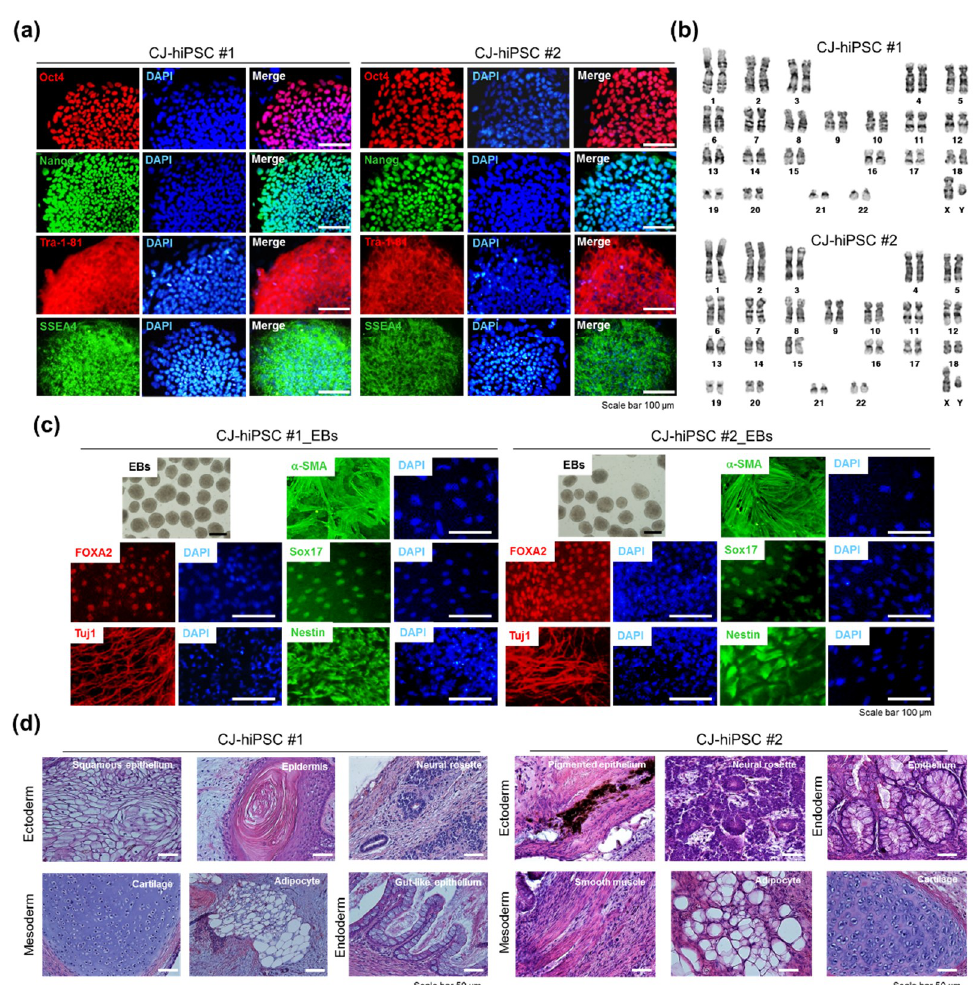
Figure 4. Characterization of CJ ‑extract‑induced hiPSC clones ( CJ ‑hiPSCs). ( a ) Representative images of CJ ‑hiPSCs#1 and #2 depicting typical morphology and expression of pluripotency markers, including Oct4, Nanog, SSEA‑4, and Tra‑1‑81. Scale bars, 100 μm. ( b ) Normal karyotype of CJ ‑hiPSCs#1 and #2. ( c ) In vitro embryoid body (EB) differentiation of CJ ‑hiPSCs#1 and #2. Bright field images of representative EBs and immunocytochemical analysis of mesoderm (a‑SMA), endoderm (FOXA2 and Sox17), and ectoderm (Tuj1 and Nestin) markers in differentiated cells. The cells were co‑stained with DAPI (blue). Scale bars, 100 μm. ( d ) Histological analysis of teratomas derived from CJ ‑hiPSCs#1 and #2. Ectoderm was represented by neural tissue and epidermis. Mesoderm was represented by cartilage, adipocyte, and muscle. Endoderm was represented by epithelium. Scale bars, 50 μm.